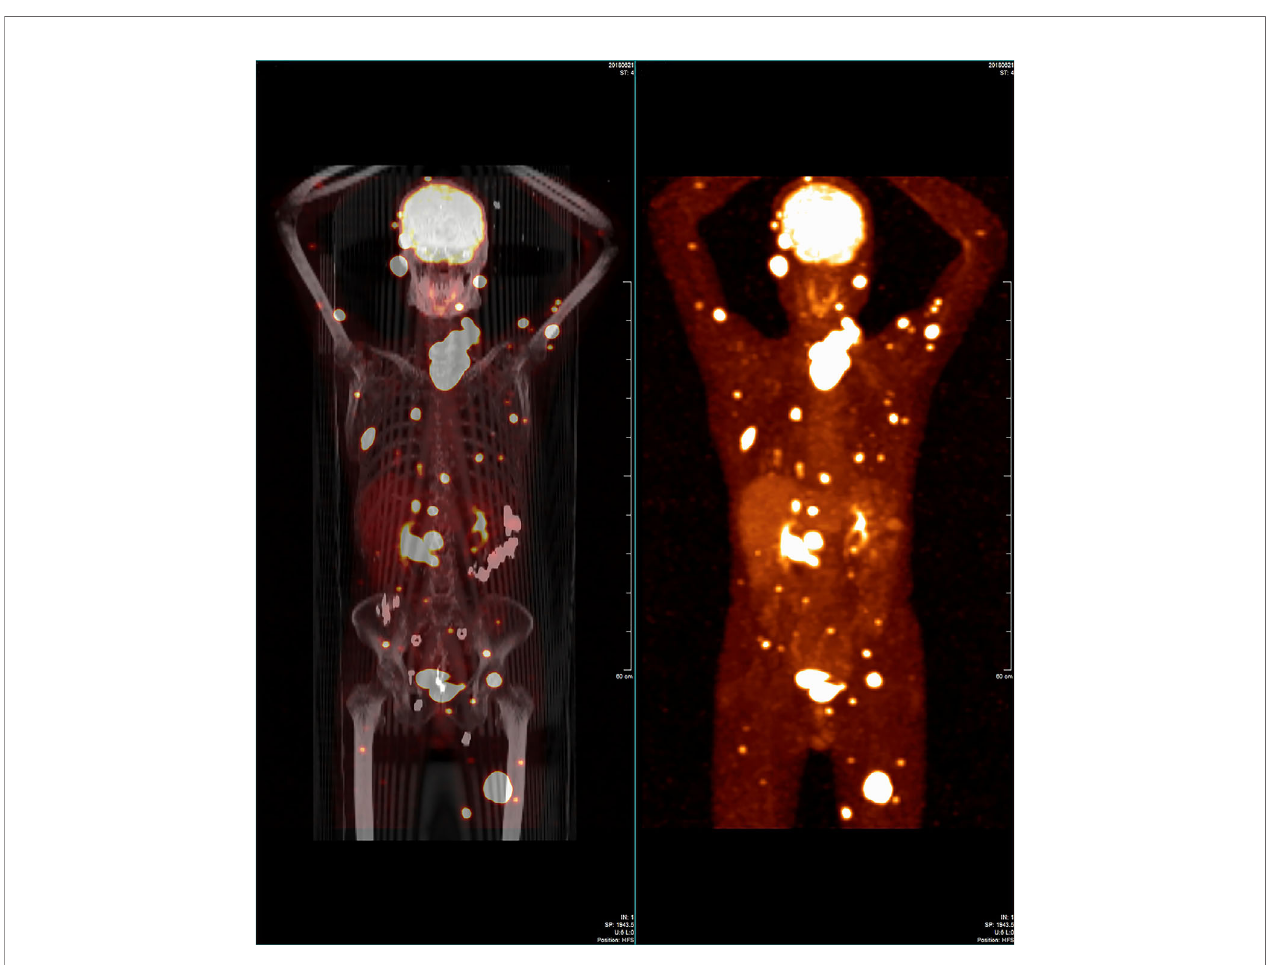
FIGURE 1 | Whole-body 18- fl uorodeoxyglucose positron-emission tomography/computed tomography image showing that many regions in the patient ’ s body had widespread abnormal